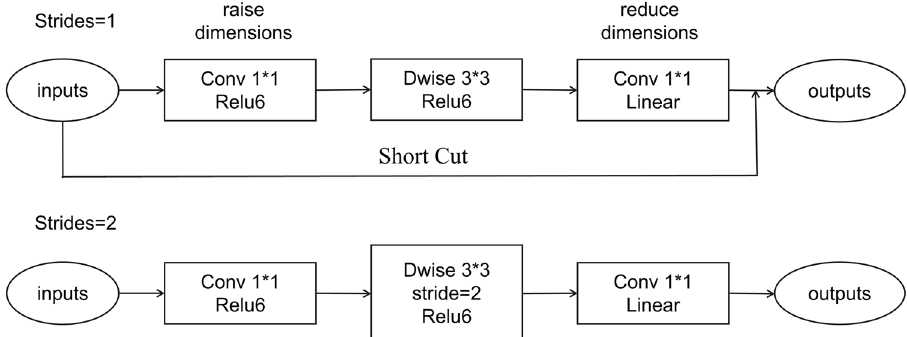
Fig. 4 The image is improved depthwise separable convolu- tion; if strides = 1, we need to shortcut that means using residual